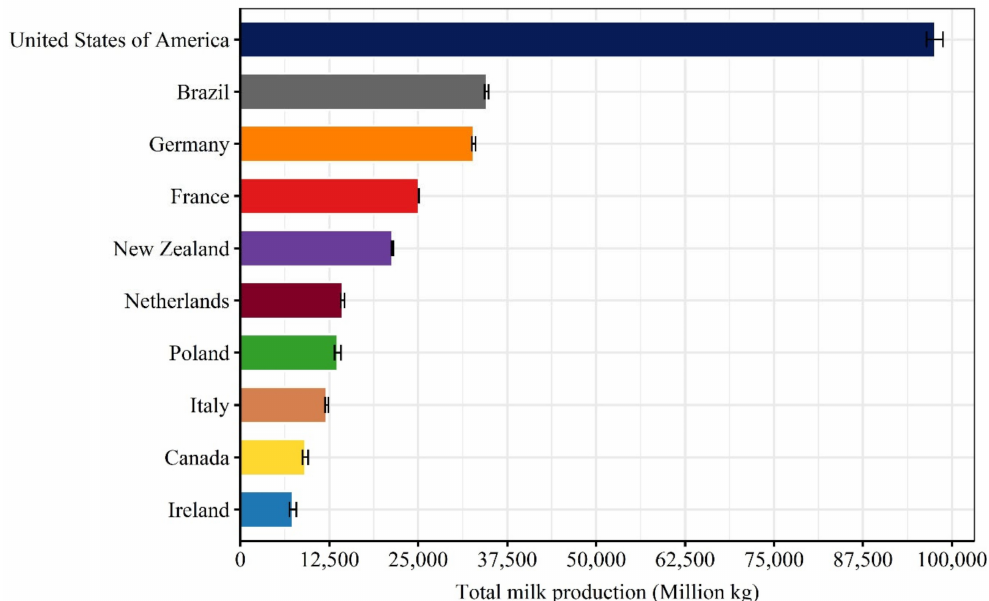
Figure 3. Top 10 high milk-producing countries based on total milk production averaged over the years 2016 to 2018. Columns represent the averages followed by the standard deviation (error bars). The list of countries is limited to those for which we were able to provide sufficient and reliable data on the length of productive life. Data sources are provided